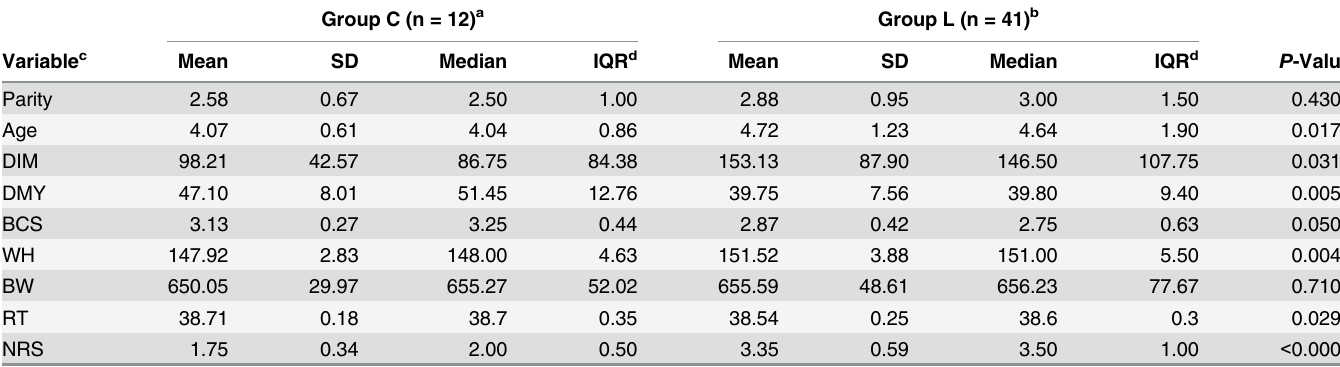
Table 2. Clinical variables of non-lame (group C) and lame (group L)